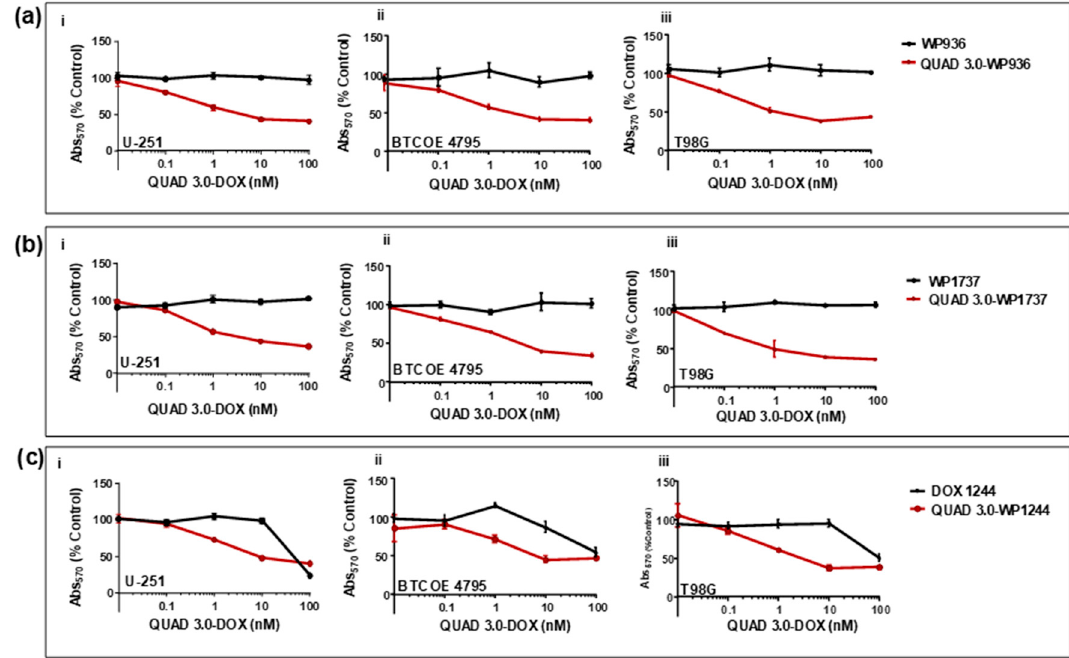
Figure 6. QUAD 3.0-Dox conjugates are cytotoxic to established and patient-derived GBM cell lines. MTT assay of ( a ) unconjugated WP936 and QUAD 3.0-WP936 conjugates in ( i ) U-251, ( ii ) BTCOE 4795, and ( iii ) T98G cells; ( b ) unconjugated WP1737 and QUAD 3.0-WP1737 conjugates in ( i ) U-251, ( ii ) BTCOE 4795, and ( iii ) T98G cells; and ( c ) unconjugated WP1244 and QUAD 3.0-WP1244 conjugates in ( i ) U-251, ( ii ) BTCOE 4795, and ( iii ) T98G cells. Table 2. The IC 50 values for QUAD 3.0 conjugates with Dox derivatives.